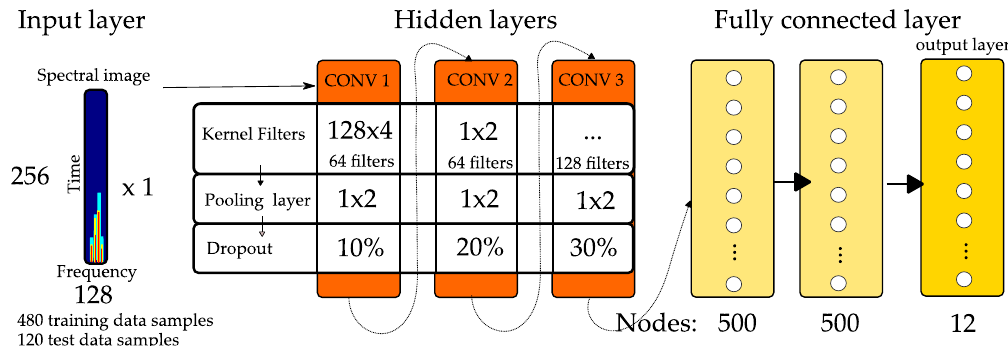
Figure 9. CNN structure proposed by [23] used to classify PD spectrograms.